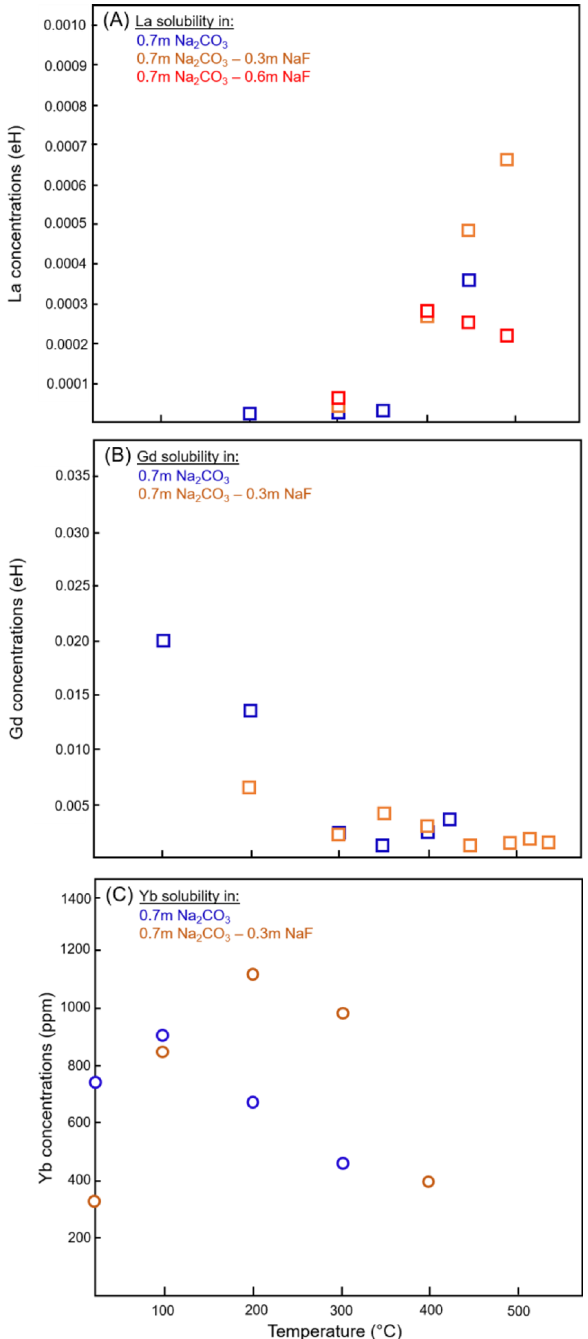
Fig. 2 Effect of temperature on the concentrations of La(A), Gd (B), and Yb (C) in Na 2 CO 3 ± NaF solutions. Solubility trends for La and Gd